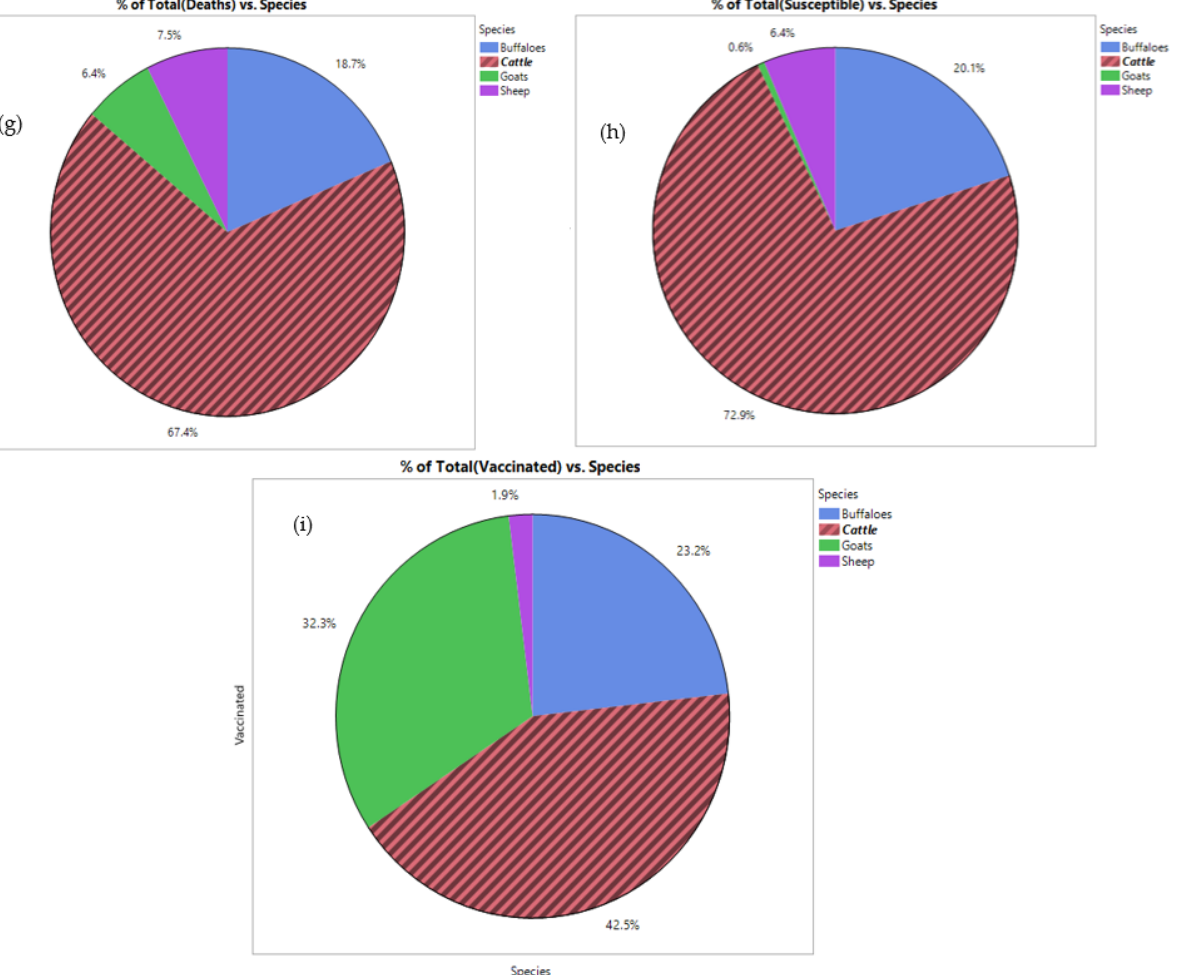
Figure 3. Correlation between mortality, susceptible and total morbidity among buffaloes ( a , d , g ), cattle ( b , e , h ), goat and sheep ( c , f , i ) and the total morbidity in the period between 2005 and 2019. 2. Virulence Factors and Associated Genes in Pasteurella multocida B:2 and